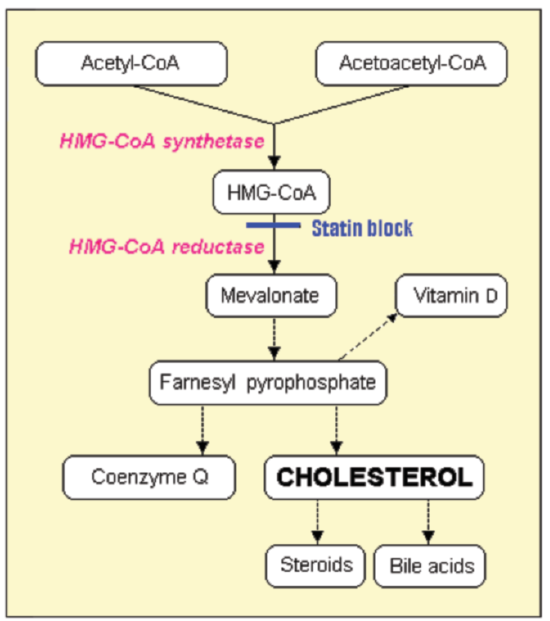
Figure 1. Metabolic pathways of cholesterol. Dotted lines indicate multienzyme